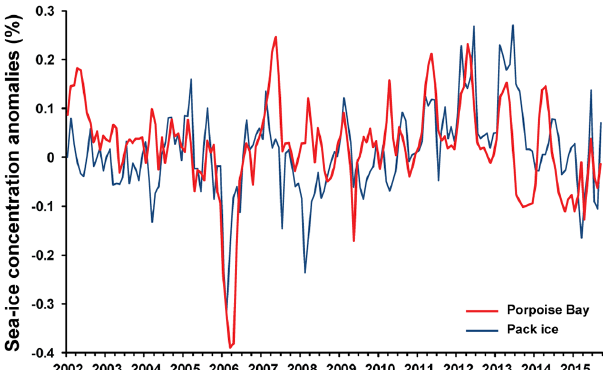
Figure 7. Mean monthly sea ice concentration anomalies from November 2002 to June 2016. The red line indicates sea ice con- centration anomalies in Porpoise Bay and the blue line indicates pack-ice-concentration anomalies.